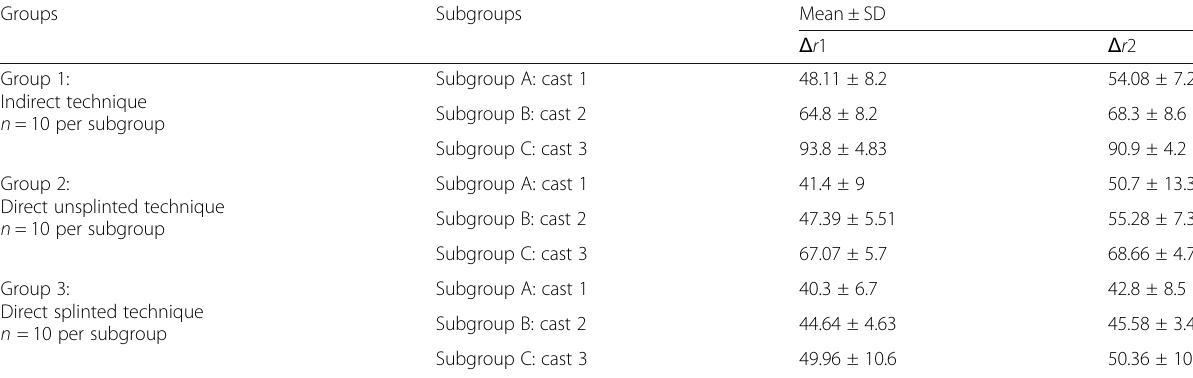
Table 1 Mean and standard deviation values of each of the two Euclidean distances measured in micrometer ( μ m) for the study groups